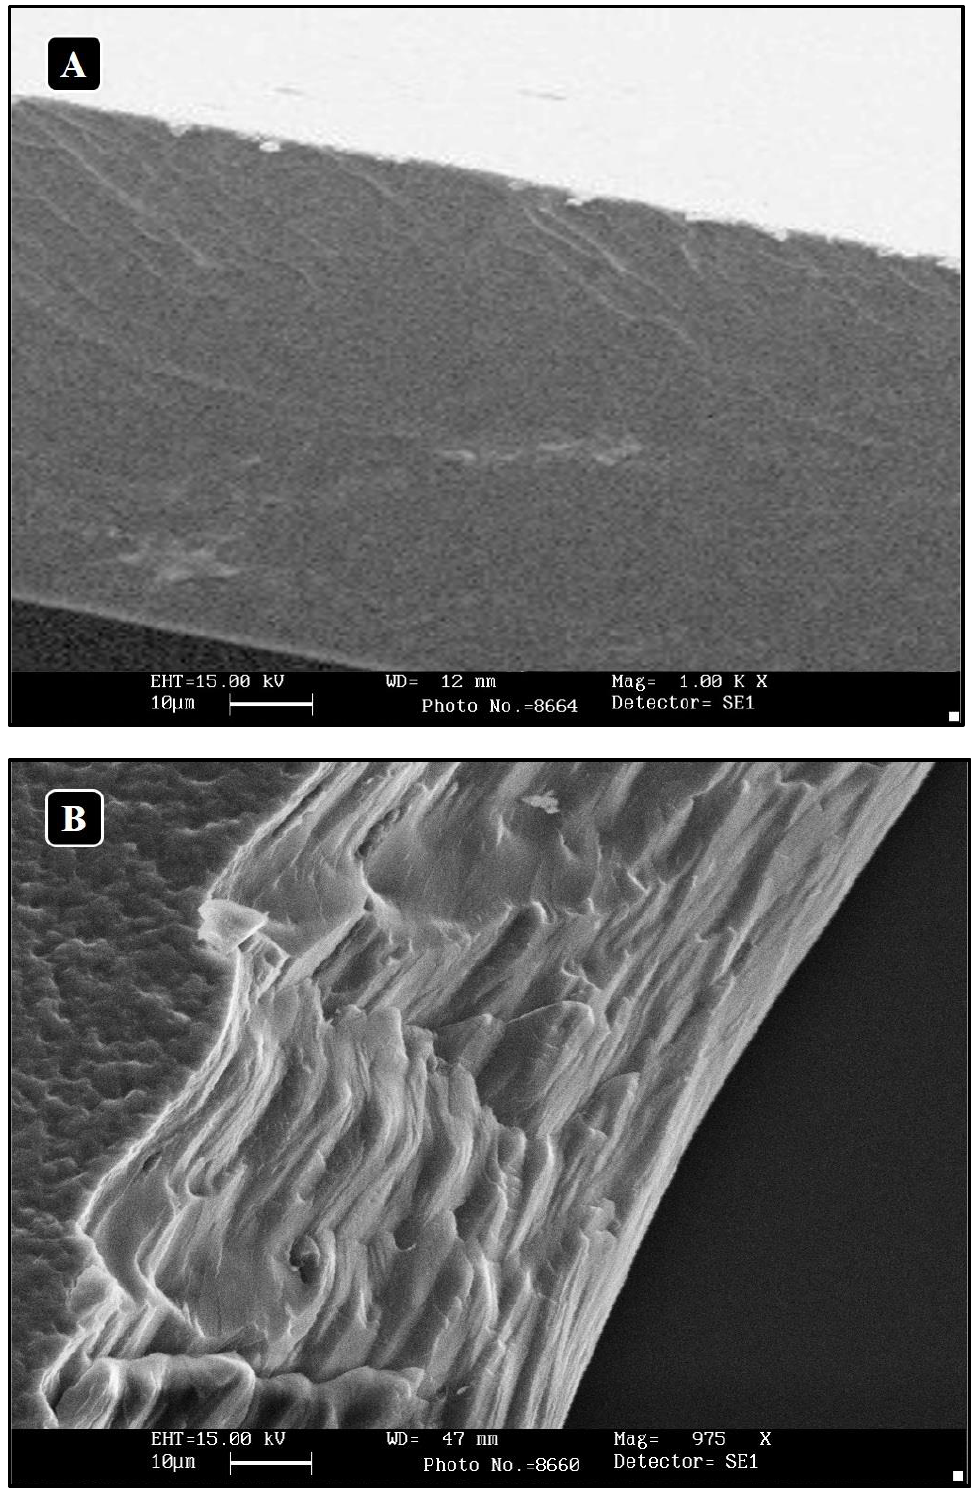
Figure 5. SEM images of the surface and cross-section of Salep mucilage edible ( A ) control and ( B ) indicator films (5 % v/v SA As ).